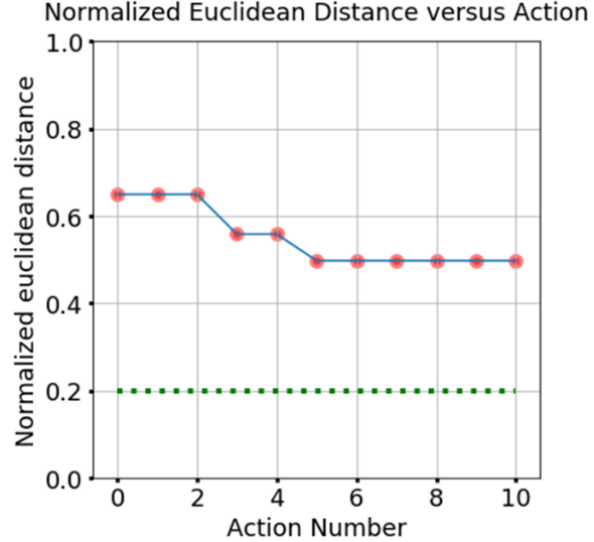
Figure 19. Progression of the normalized Euclidean distance (blue line) of the system states during the actual well circulation operation (shown by the green dotted line, here taken to be a state at a normalized Euclidean distance of